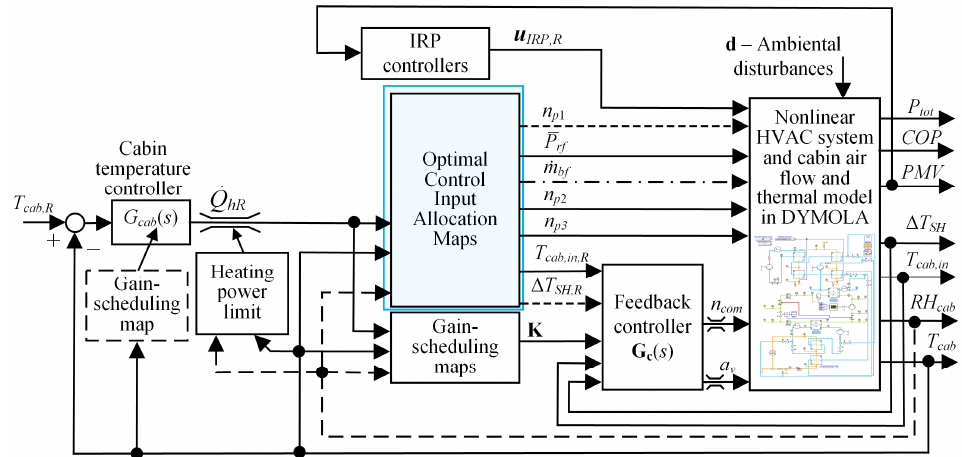
Figure 10. Overall hierarchical structure of HVAC control system including decoupled IRP-based PMV controller.